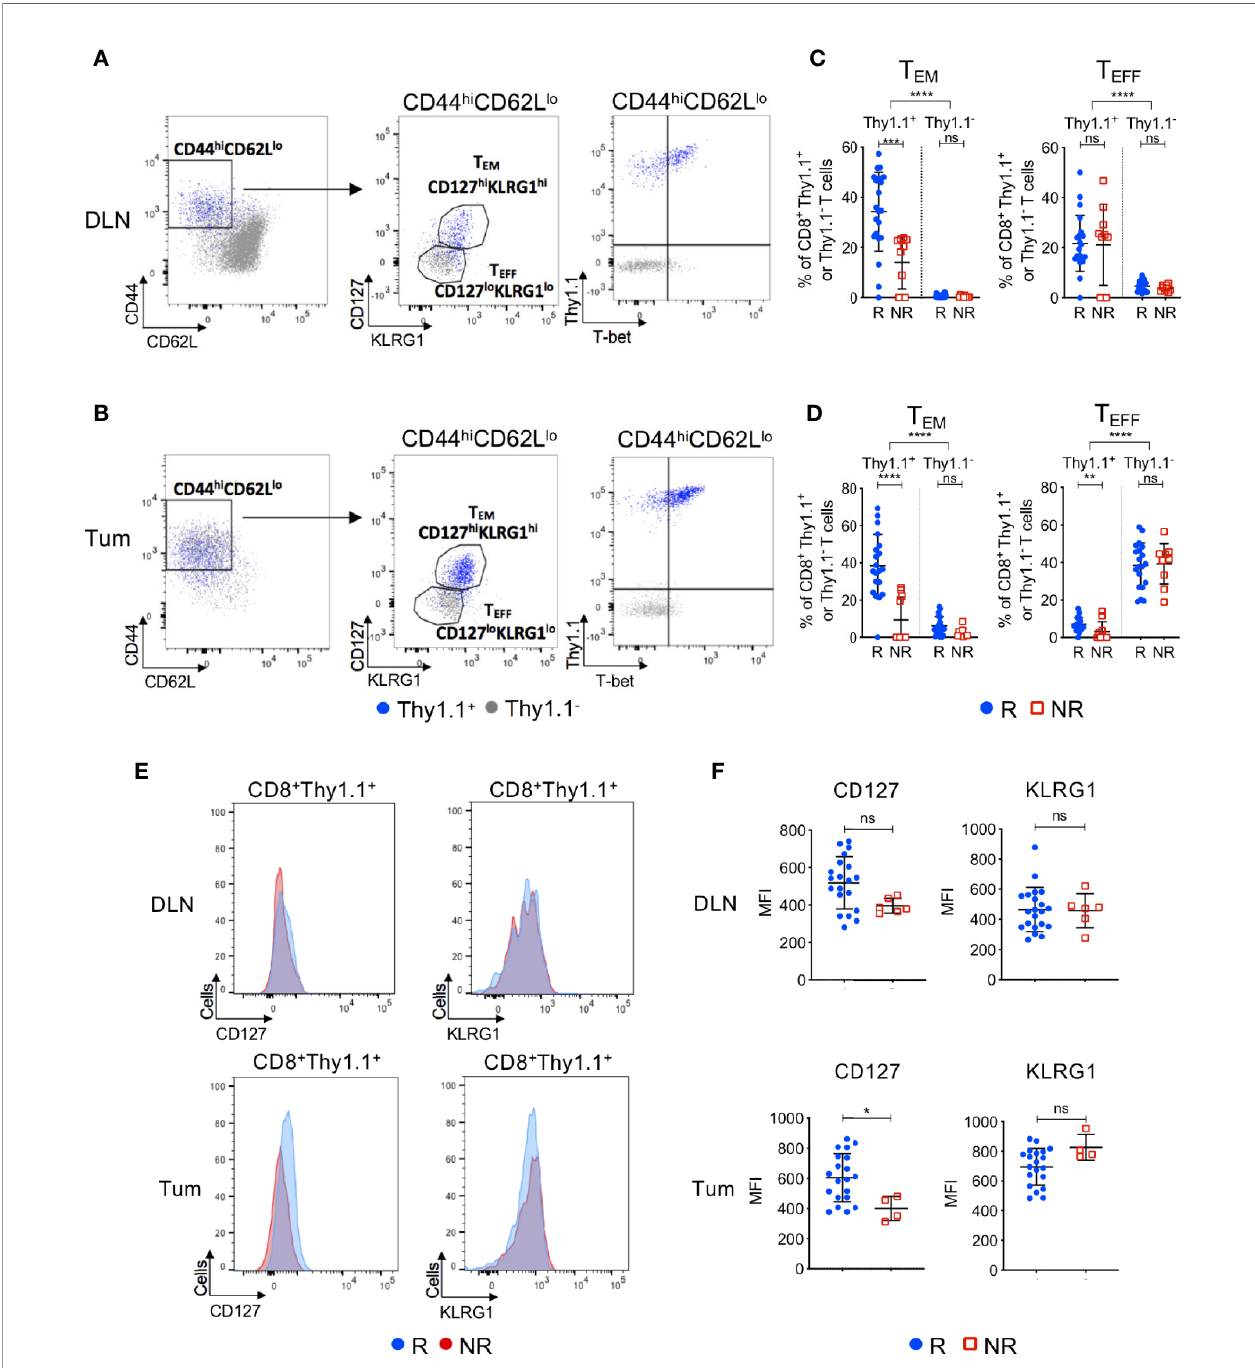
FIGURE 4 | Tumor in fi ltrating tumor antigen-speci fi c CD8 + T cells acquire an effector memory phenotype in ICT responding animals. Representative FACs plots comparing CD8 + Thy1.1 + (blue) and CD8 + Thy1.1 − (gray) T cell phenotype in post-treatment (A) DLNs and (B) tumors. Cells were analyzed for CD44, CD62L, CD127, KLRG1 and T-bet expression. Gates on the FACS plot represent effector memory (T EM ; CD44 hi CD62L lo CD127 hi KLRG1 hi ) and effector (T EFF ; CD44 hi CD62L lo CD127 lo KLRG1 lo ) T cell subsets. Graphs representing frequencies of tumor antigen-speci fi c (CD8 + Thy1.1 + ) and endogenous (CD8 + Thy1.1 − ) T cells that exhibit T EM or T EFF phenotypes in (C) DLNs and (D) tumors, grouped by response/non-response to ICT. (E) Representative histograms comparing CD127 and KLRG1 expression on activated (CD44 hi CD62L lo ) CD8 + Thy1.1 + T cells between responding and non-responding DLNs (top) and tumors (bottom). (F) Median fl uorescence intensity (MFI) expression of CD127 and KLRG1 on CD8 + Thy1.1 + T cells in DLNs (top) and tumors (bottom) represented as dot plots. Data shown as mean ± SD. Mann-Whitney U tests were used to compare between both responders and non-responders, and between Thy1.1 + and Thy1.1 − T cells for each T cell phenotype; *P ≤ 0.05, **P ≤ 0.01, ***P ≤ 0.001, ****P ≤